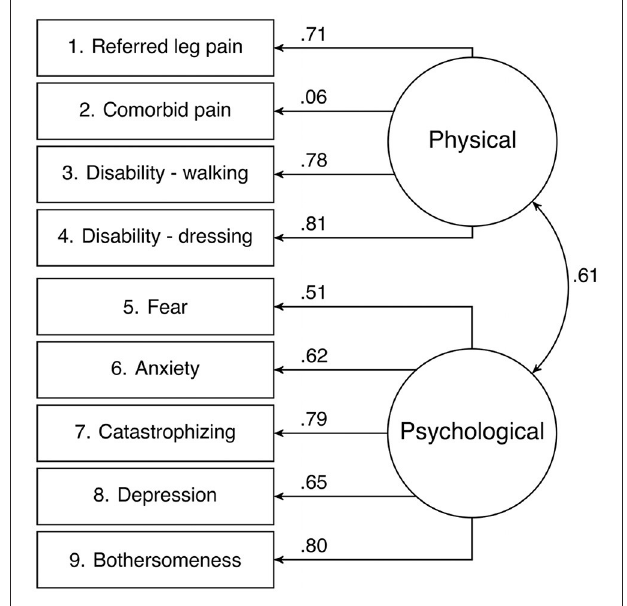
FIGURE 1 | Confirmatory factor analysis of the Start Back Screening Tool evaluating a two correlated factors